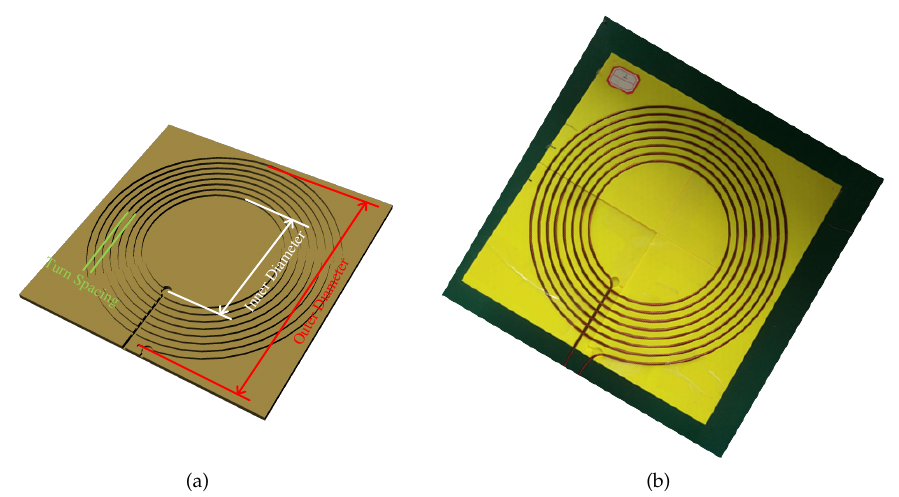
Figure 7. ( a ) the rendering-graph of coil; ( b ) the photograph of coil.